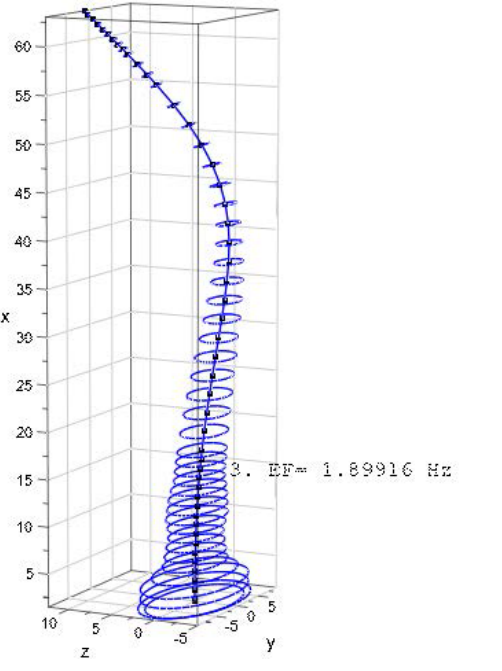
Figure 7. Second flapwise eigenmode.